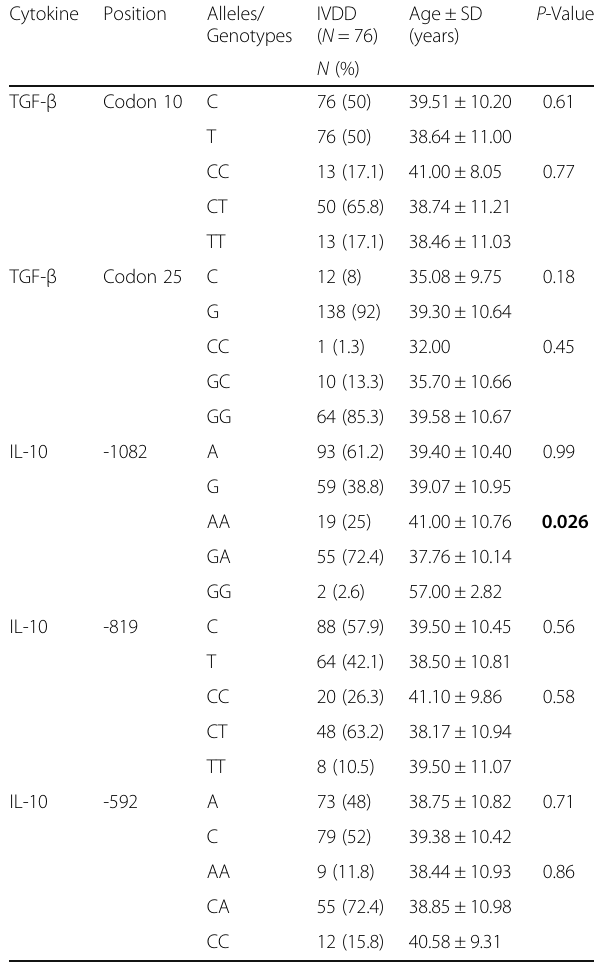
Table 4 Association of Age and Allele/Genotype Frequencies of IL-10 and TGF- β Single Nucleotide Polymorphisms Cytokine